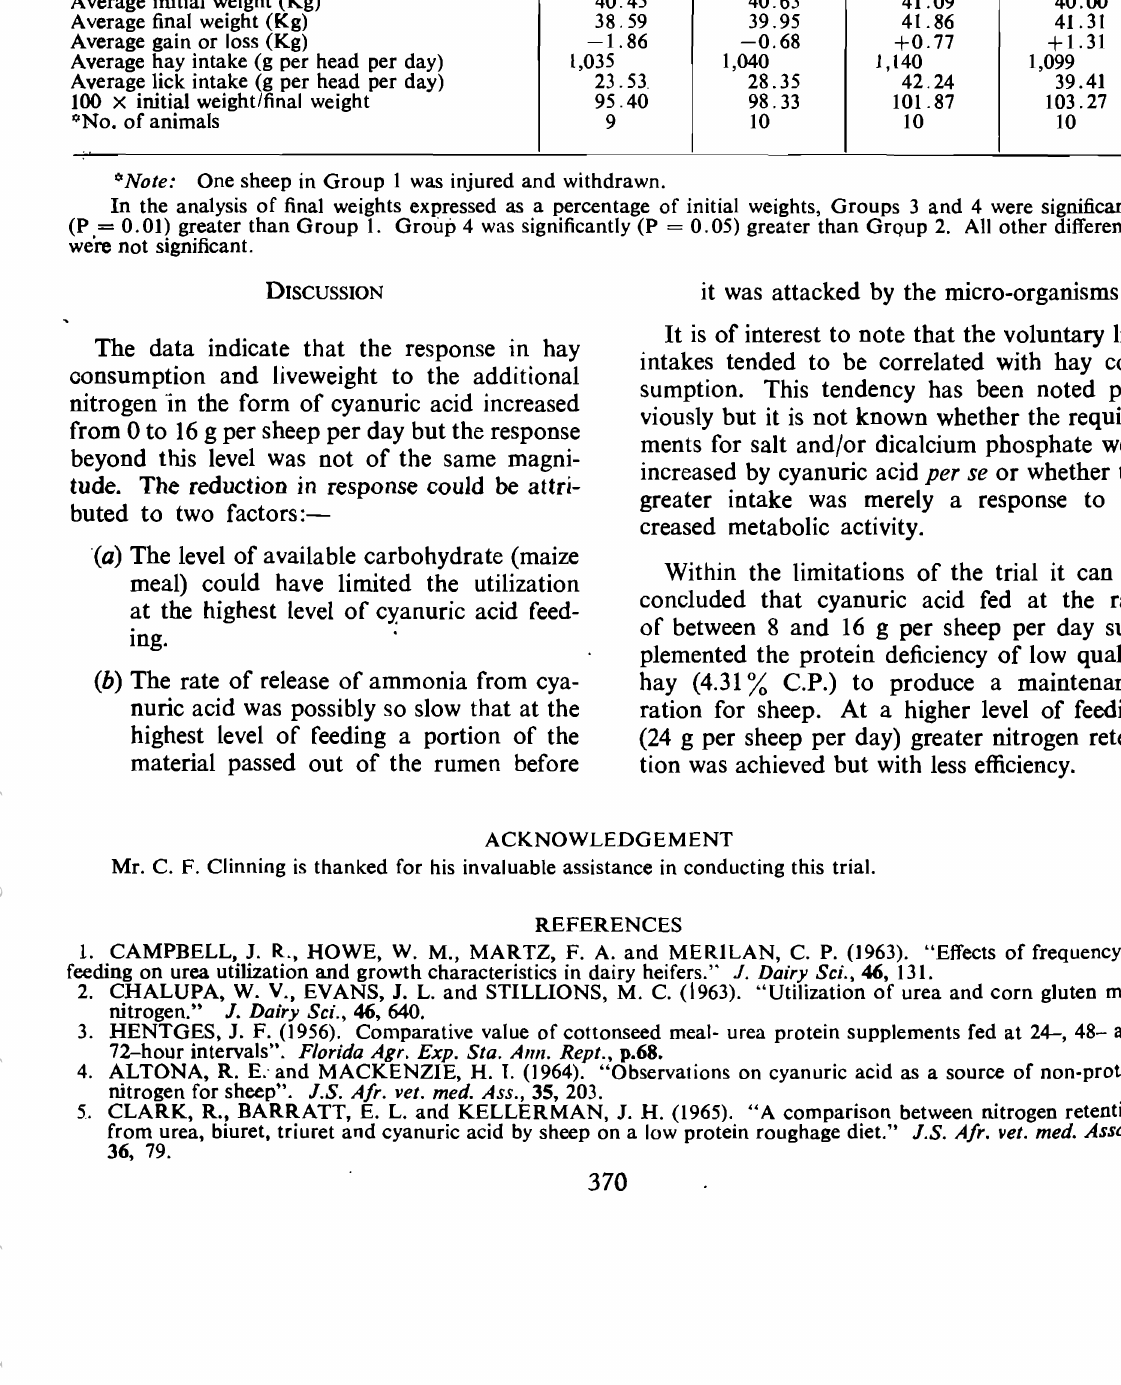
TABLE I.-LIVEWEIGHTS AND L1VEWE1GHT CHANGES OF SHEEP AND LICK AND HAY CONSUMPTION BY SHEEP OVER A PERIOD OF 77